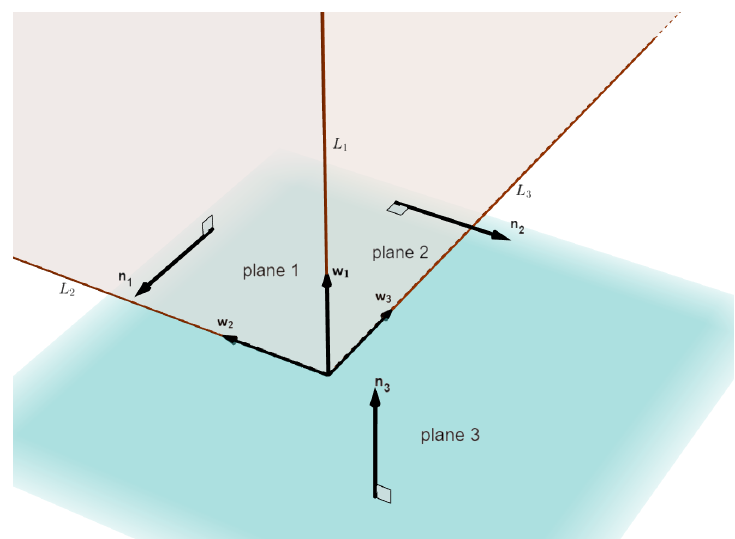
Figure 4. Geometric model in the LiDAR coordinate system.